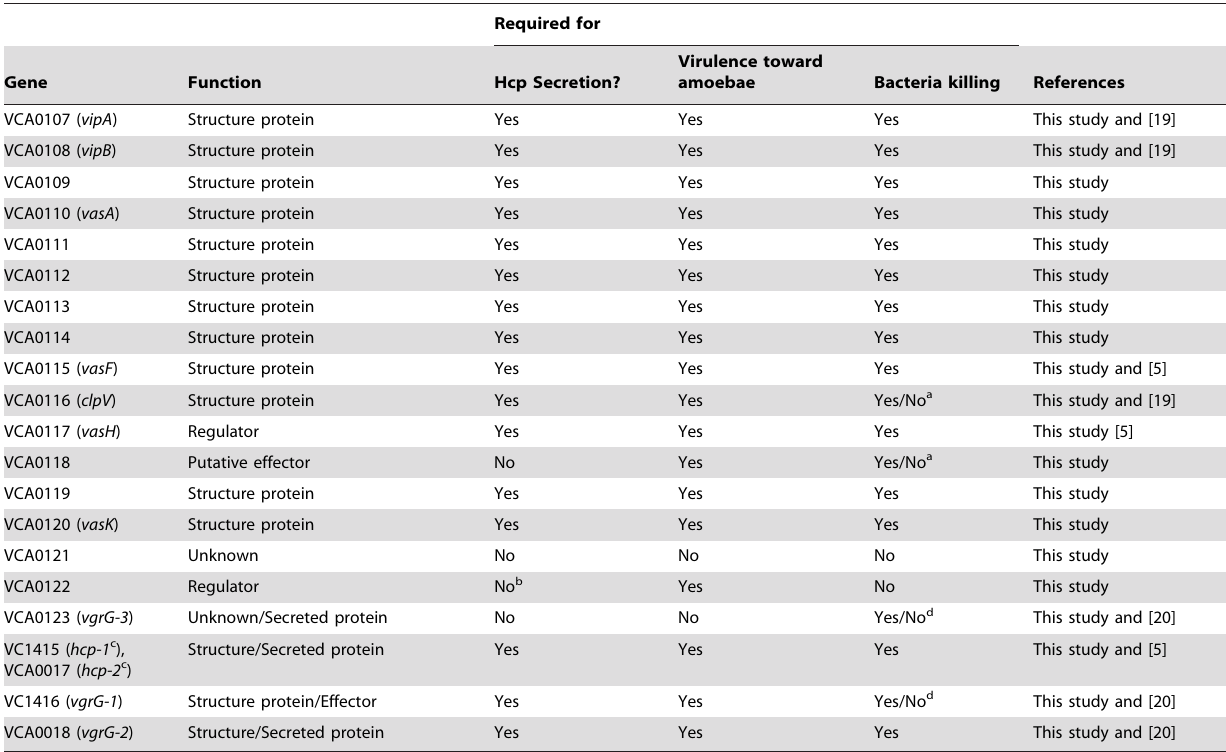
Table 1. Functions of genes encoded in T6SS locus of V. cholerae